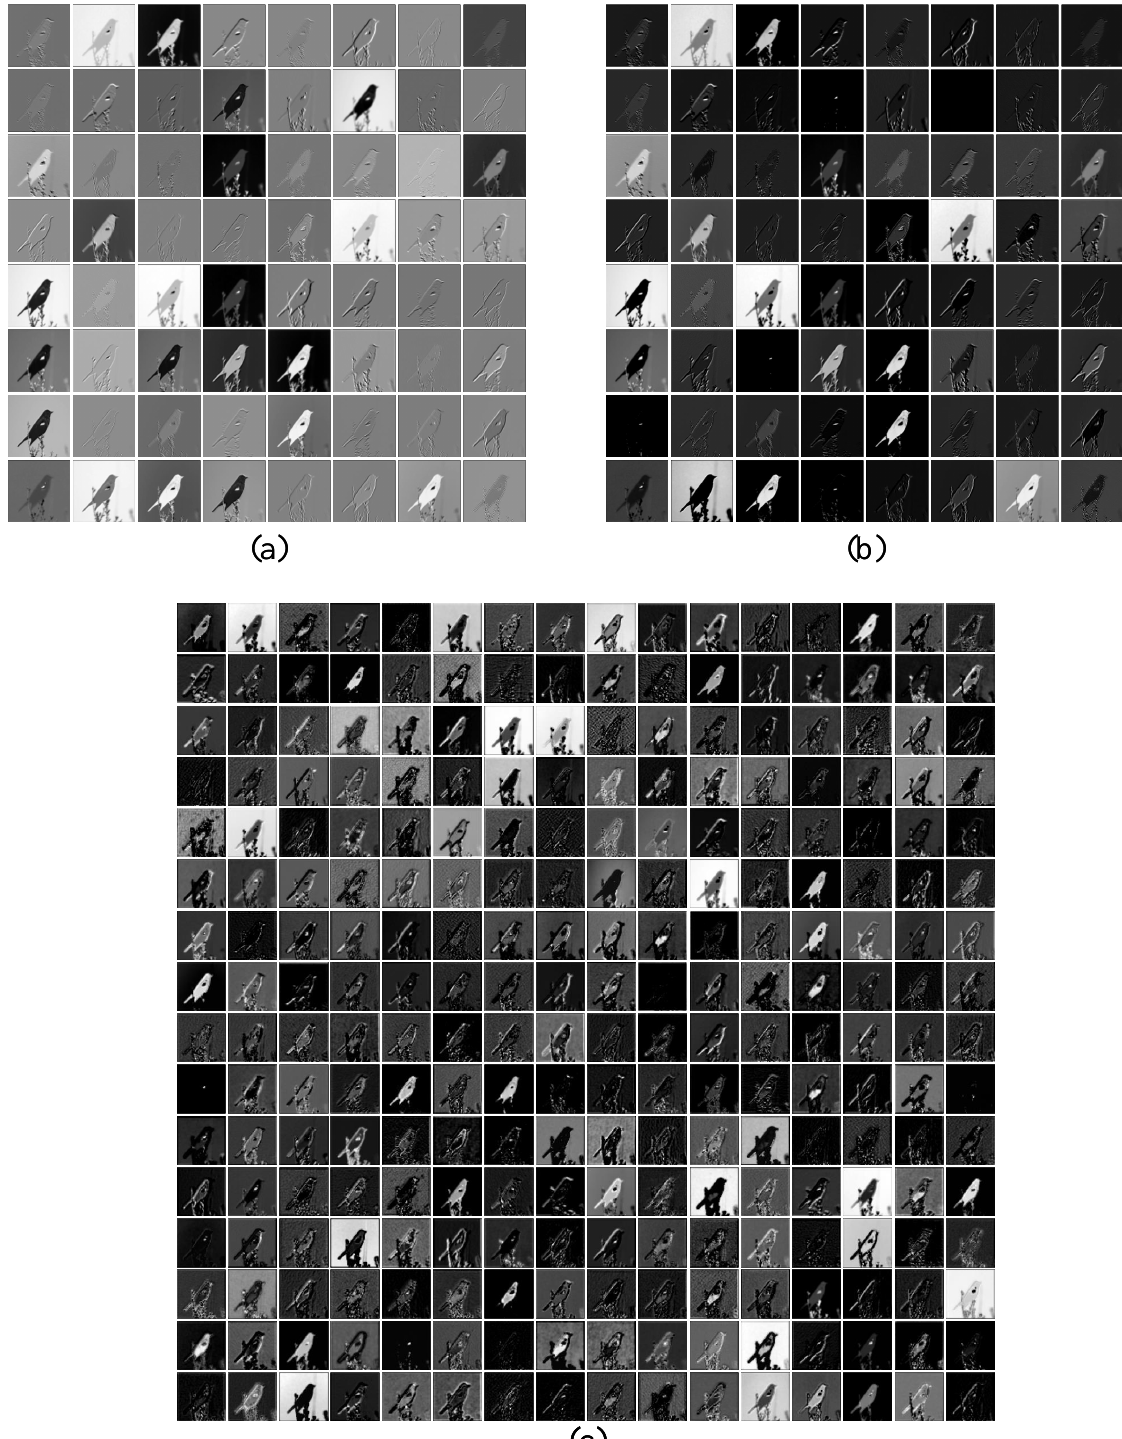
Figure 7. Visualization of MSiSQRT-COV based on the baseline ResNet50. ( a ) Visualization of the first layer of the network, ( b ) Visualization of the third layer of the network, ( c ) Visualization of the fifth layer of the